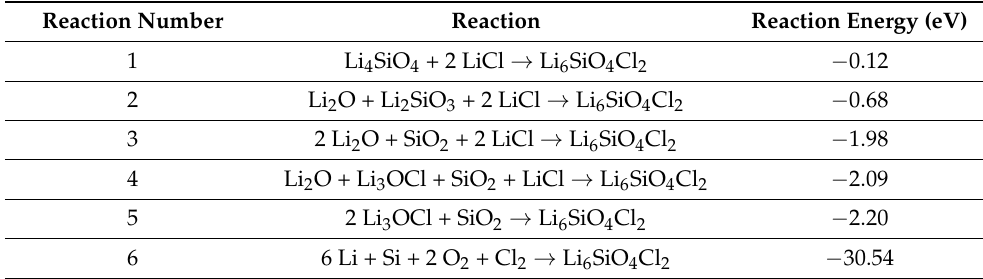
Table 4. Calculated reaction energies for the formation of Li 6 SiO 4 Cl 2